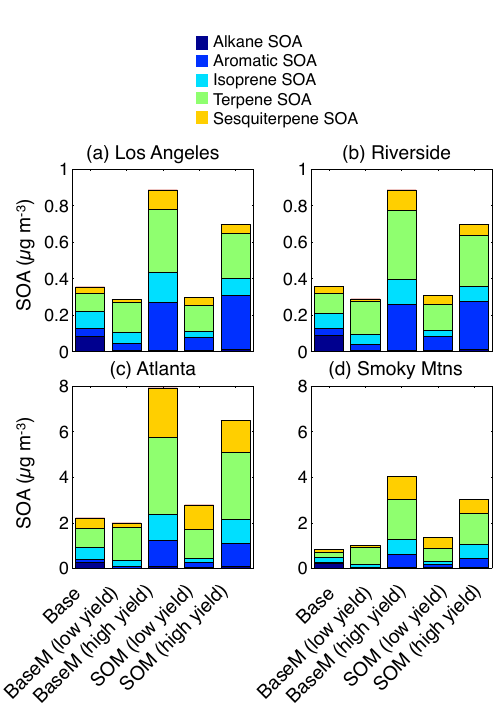
Figure 1. 14-day averaged SOA concentrations at Los Angeles (a) , Riverside (b) , Atlanta (c) and Smoky Mountains (d) for the Base, BaseM, and SOM simulations resolved by the